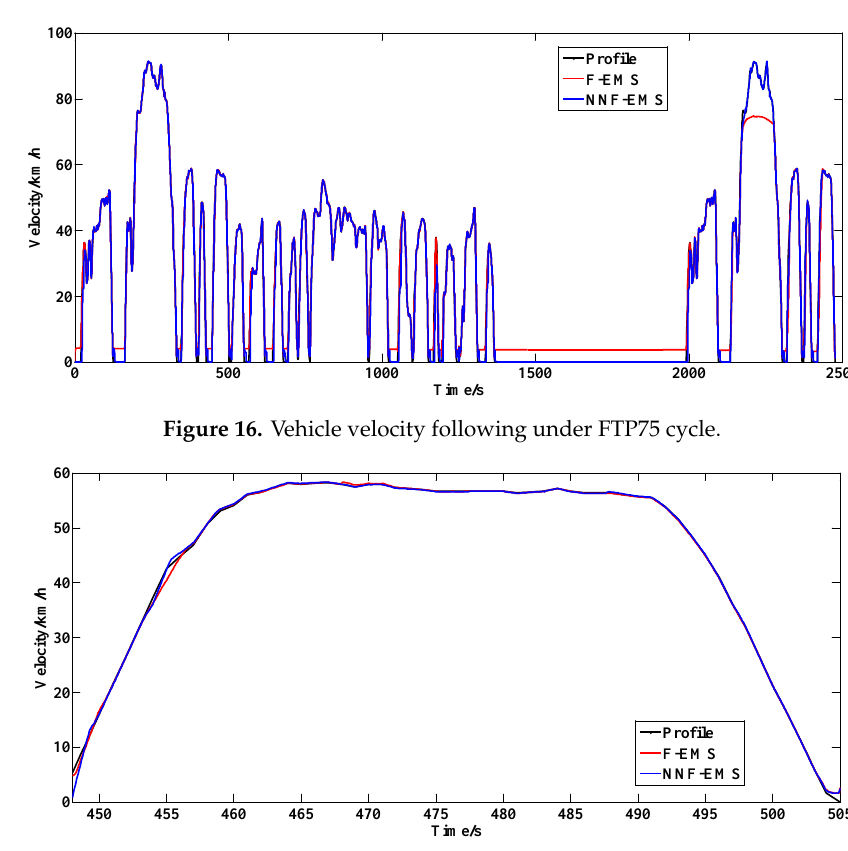
Figure 17. Vehicle velocity following under FTP75 cycle (partial enlargement).